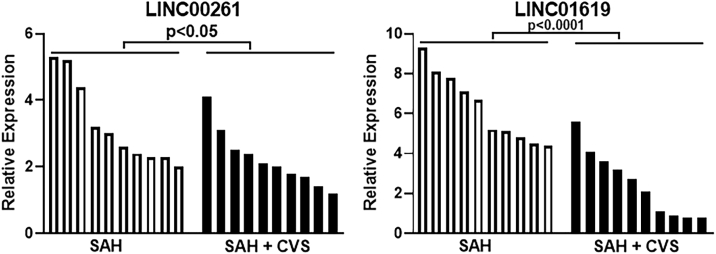
Expression of LINC00261 and LINC01619 in Individual Patient SamplesExpression levels of lncRNAs LINC00261 and LINC01619 in individual samples representing patients with SAH (without CVS) and those with SAH and CVS. Values plotted are mean ± 95% CI.